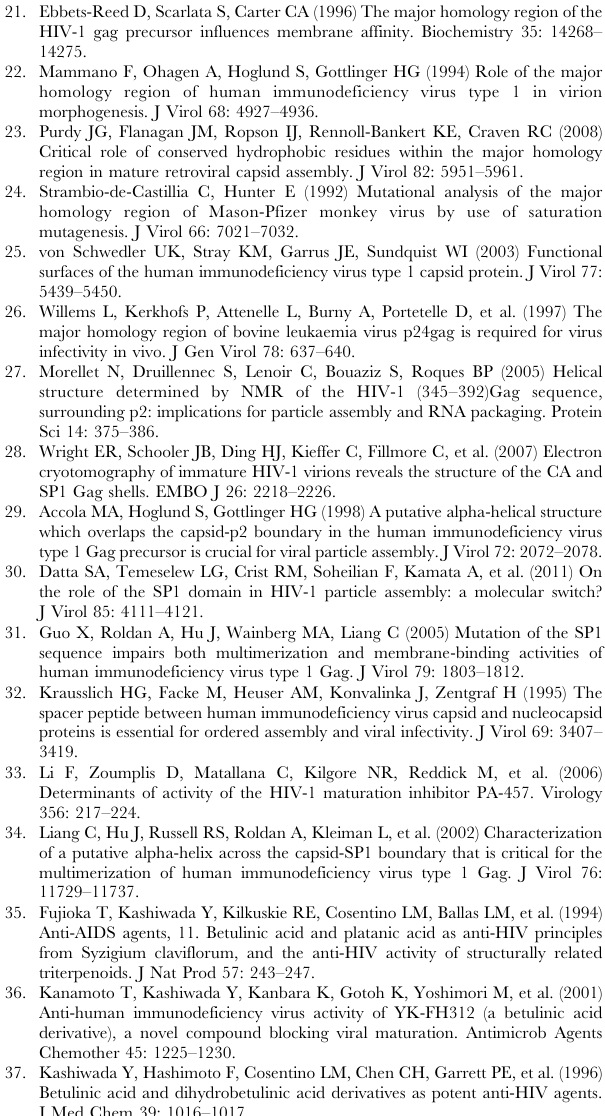
Figure S3 PF-46396-dependent MHR mutants are defective for Gag multimerization. Gag multimerization was evaluated in a cell- based assay described in the Materials and Methods. WT and the non-myristylated Gag mutant (1GA) served as positive and